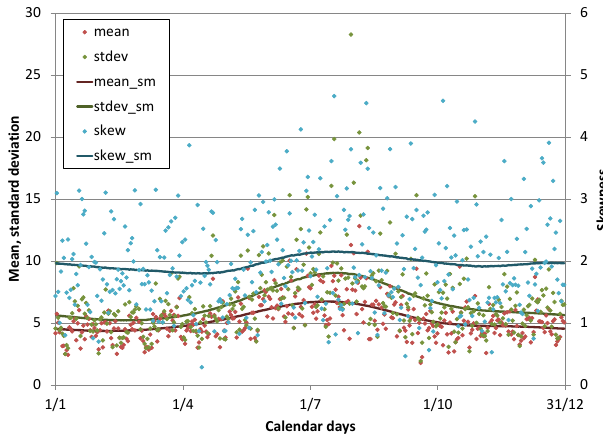
Figure 3. Annual cycle of the mean, standard deviation, and skew- ness of daily precipitation totals at Churáˇnov station. Individual points represent the values of the mean, standard deviation, and skewness calculated for each calendar day taking into account the period of 1961–2010; curves depict data smoothed using the Gaus- sian